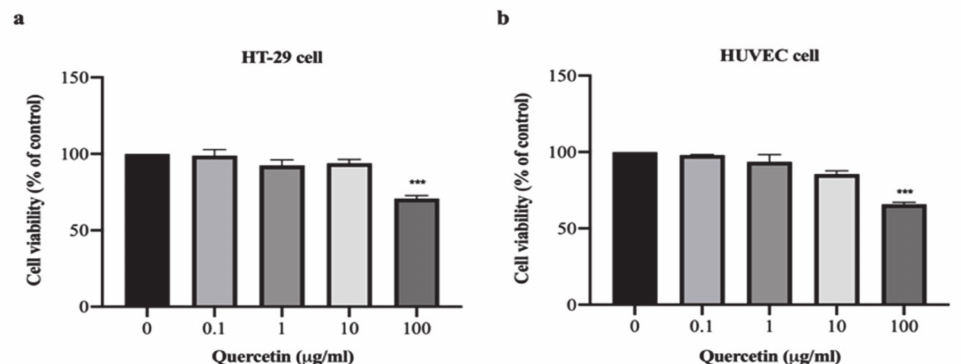
Figure 1. Effect of quercetin on cell proliferation in HT-29 and HUVEC cells. Cell proliferation of HT-29 and HUVEC cells treated with quercetin at various concentrations for 24 h was determine using MTT assay. The cell viability of HT-29 cells ( a ) and HUVEC cells ( b ) Bar graph were represented as mean ± SD, n = 3, *** p <